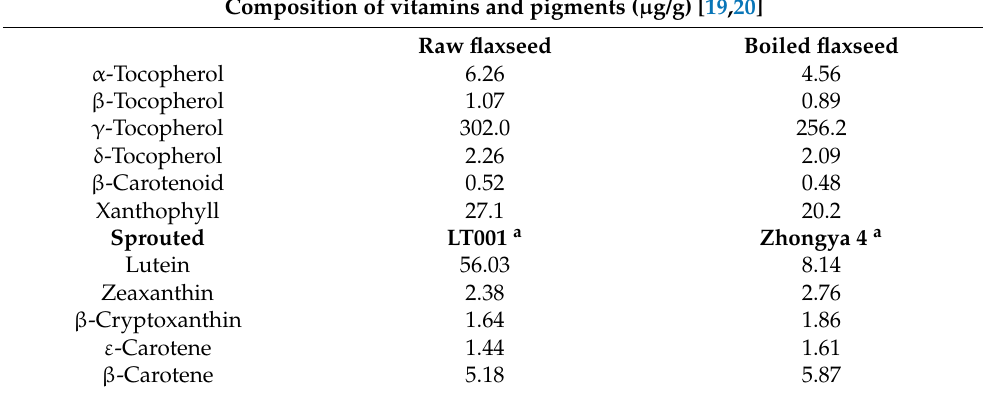
Table 1. Cont . Composition of vitamins and pigments ( µ g/g) [19,20] Raw flaxseed Boiled flaxseed α